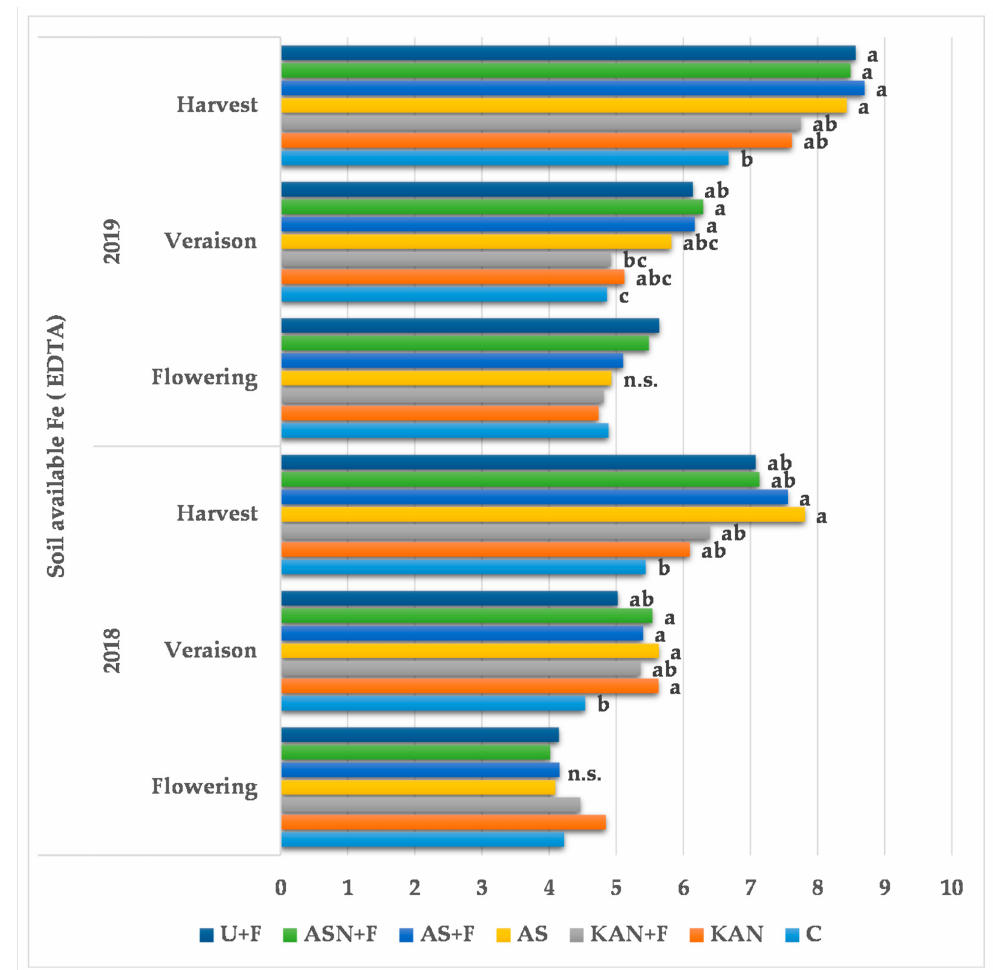
Figure 1. Influence of nitrogen fertilization on soil available Fe (EDTA) dynamic. Values marked with different letters refer to statistically significant differences ( p < 0.05) depending on treatment; n.s. (not